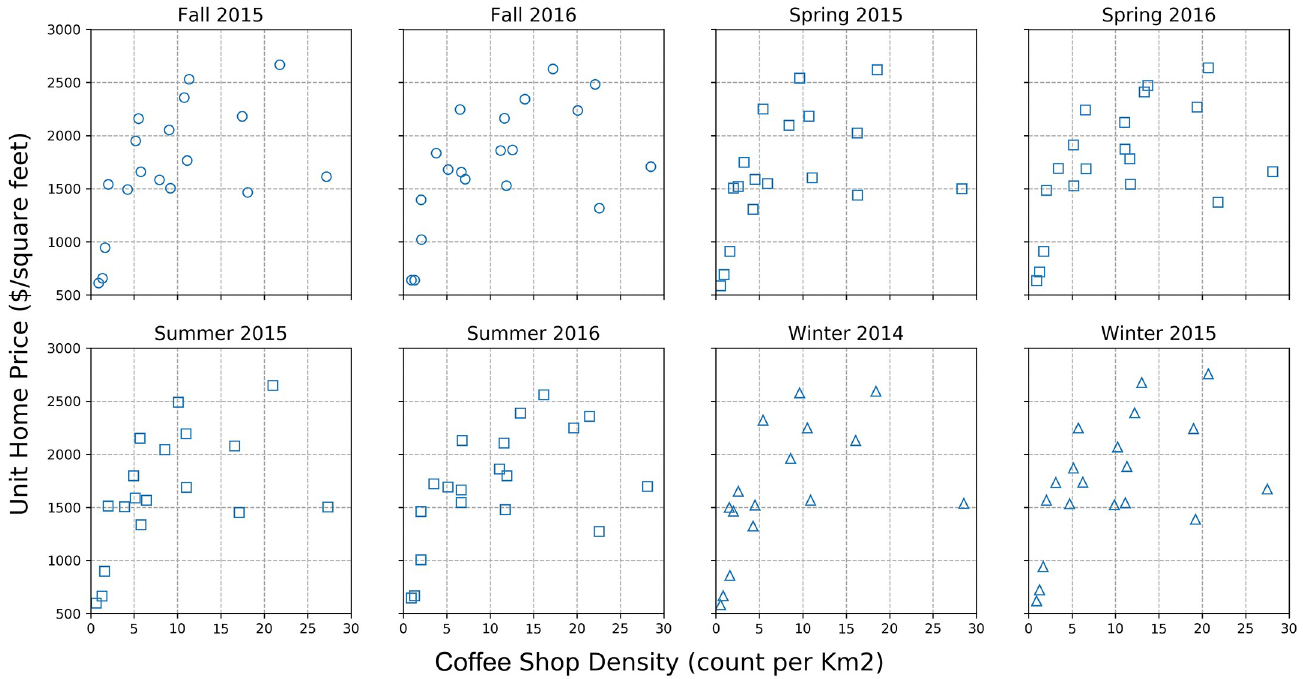
Fig 11. Log(coffee shop density) vs. log(unit home price) grouped by